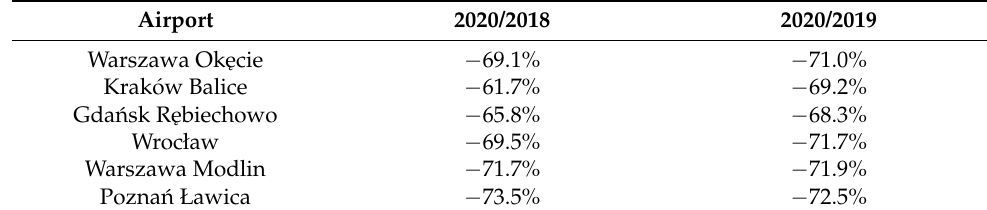
Table 1. The dynamics of changes in the number of passengers year to year.